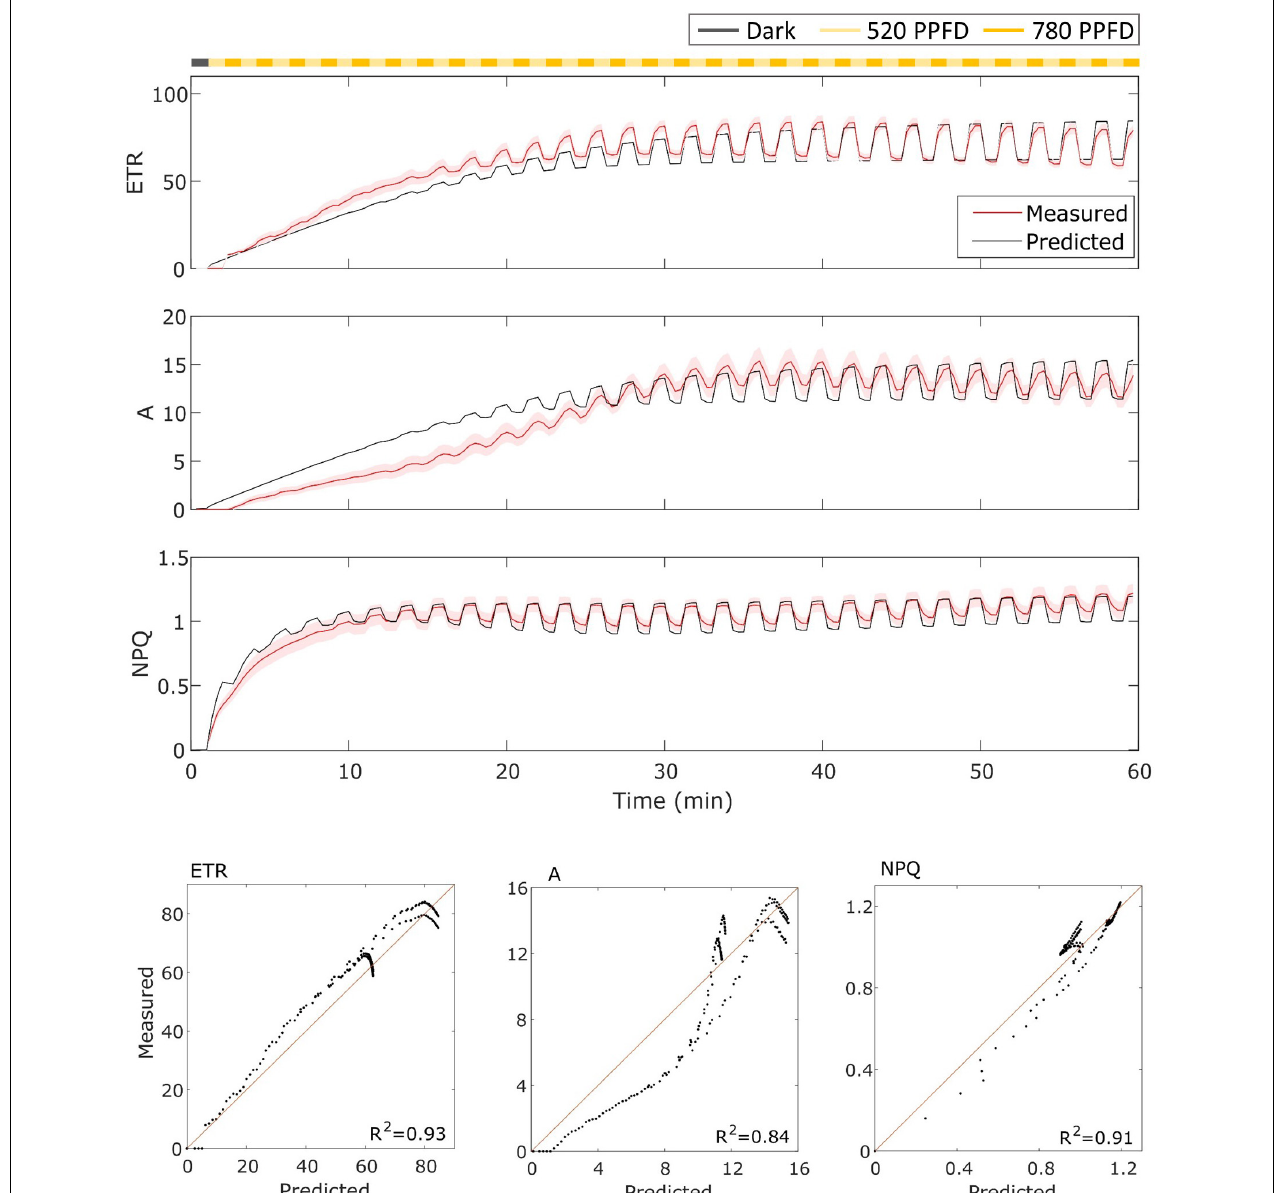
FIGURE 4 | (Top) MinnGold data (indicated in red) compared with model results (indicated in black) in the fluctuating light regime. The data are shown as means of three replicates (indicated as a red continuous line) and their standard error (indicated as the red shaded area around the mean value). (Bottom) Parity plots for ETR, A , and NPQ with related R 2